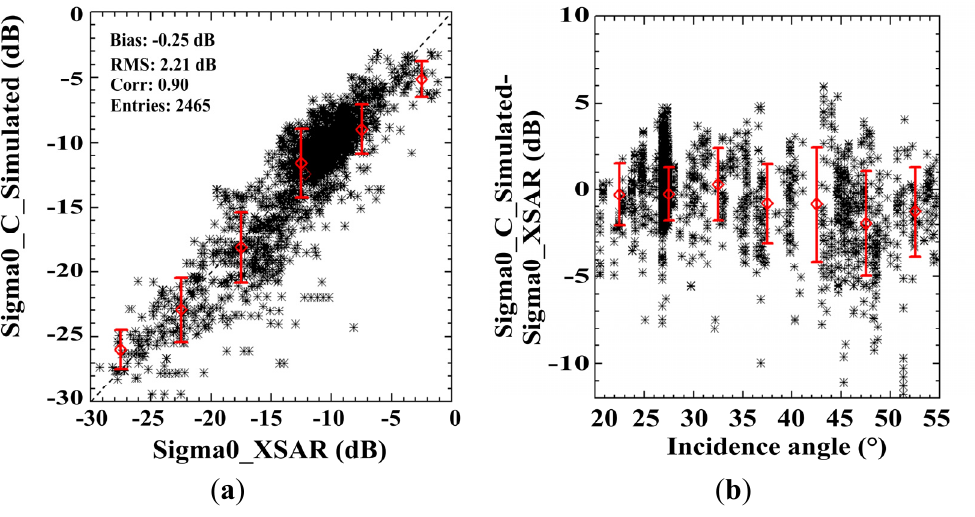
Figure 4. Comparison of the simulated normalized radar cross sections (NRCSs) using CMOD-IFR2 and the X-SAR measurements. The red error bars are plotted as the mean value ± standard deviation of the differences between the simulation and observation. ( a ) A direct comparison of the simulated C-band NRCS by the CMOD-IFR2 and X-SAR measurements; and ( b ) the differences in NRCSs simulated using CMOD-IFR2 and X-SAR measurements at various incidence angles.